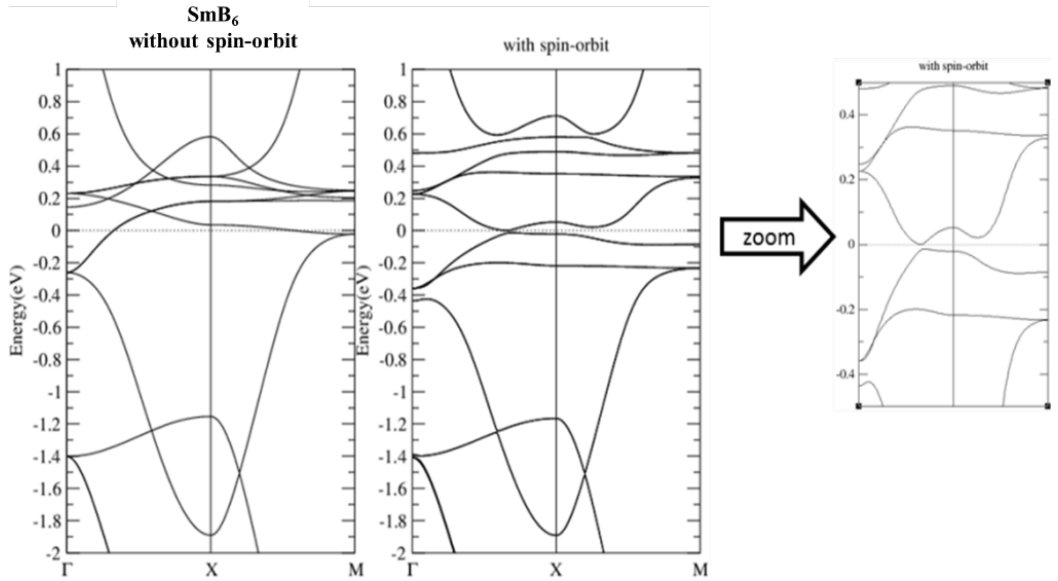
Figure 8. Band structure of SmB 6 without and with spin-orbit coupling. The right panel is the zoom-in view of the middle panel around E f .